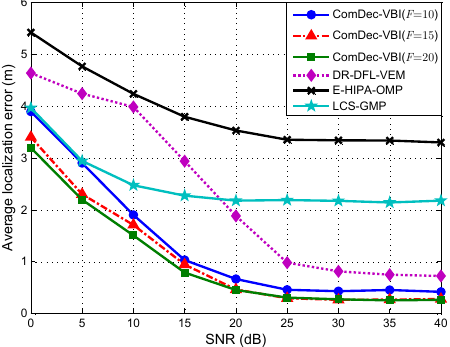
Figure 12. Average localization error with different